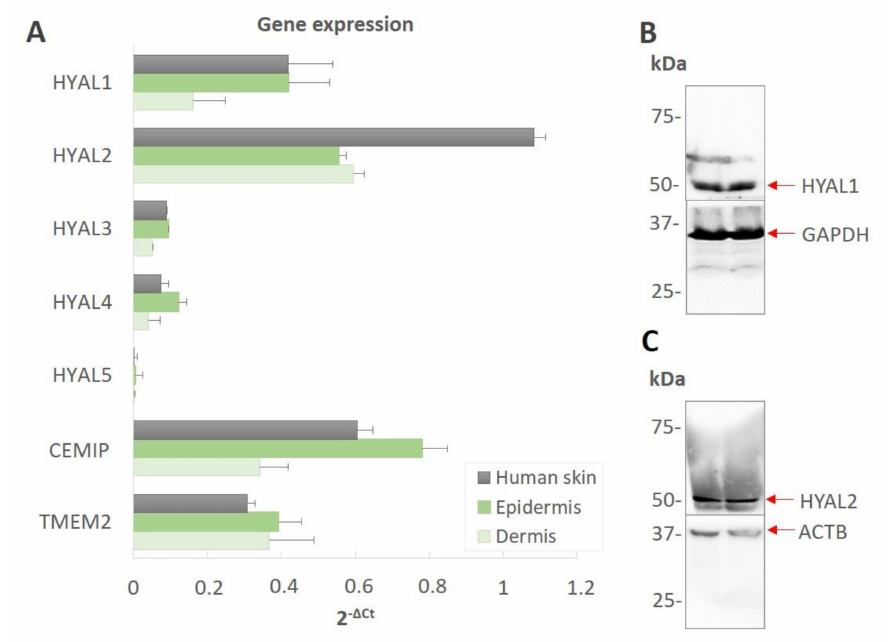
Figure 2. The expression of HYALs, CEMIP and TMEM2 in the human skin and the detection of proteins via Western blotting. ( A ) The relative expression levels of the HYAL1, HYAL2, HYAL3, HYAL4, HYAL5, CEMIP and TMEM2 transcripts were measured using RT-qPCR. The average values from three independent experiments are shown. The error bars represent the SEM. ( B ) Western blot analyses of the human skin lysates (in duplicates) with anti-HYAL1 and anti-GAPDH antibodies and ( C ) anti-HYAL2 and anti β -actin antibodies. GAPDH and ACTB were used as the loading controls. Abbreviations: Hyaluronidase (HYAL), Transmembrane Protein type II (TMEM2), Cell Mi- gration Inducing Hyaluronan Binding Protein (CEMIP), Glyceraldehyde 3-phosphate dehydrogenase (GAPDH), Actin Beta